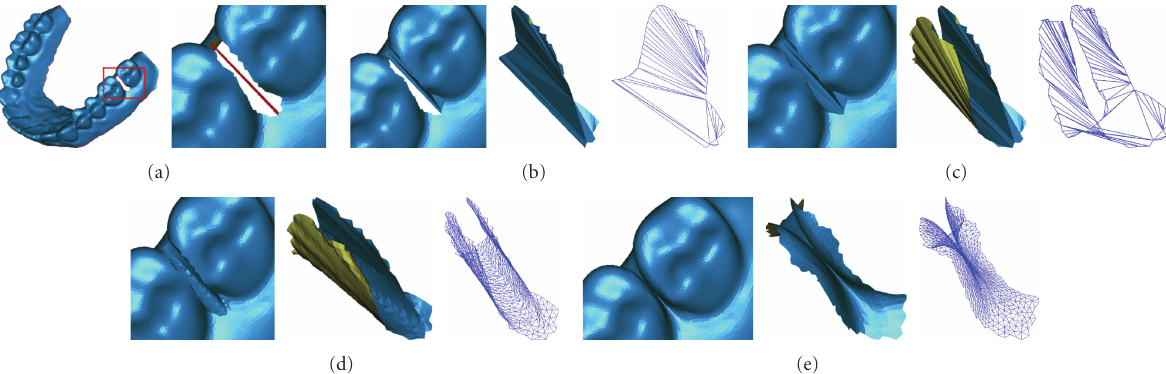
Figure 11: (a) Hole bridged to divide into two separate subholes. (b) Triangulation of the subhole. The corresponding shaded and wireframe surface patches. (c) After completely filling of the entire hole. (d) After refinement. (e) After reshaping adjustment.